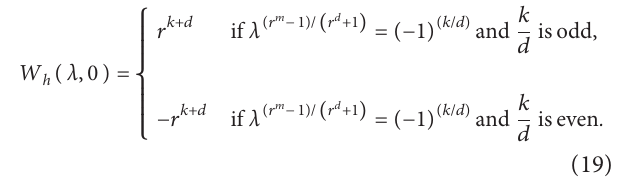
for Corollary 2 (i). S